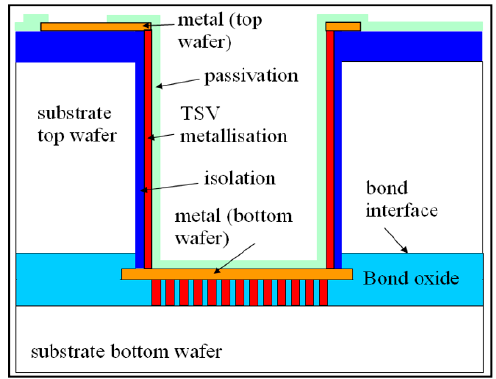
Figure 17. TSV inter-chip and chip-substrate electrical connection.